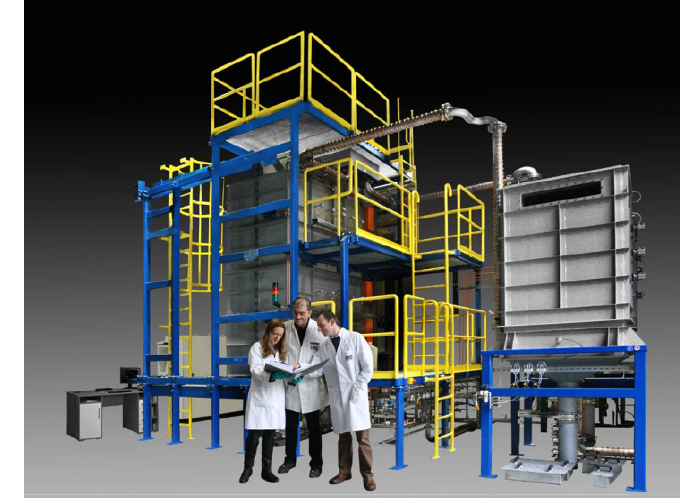
Fig. 2 – Scale up of the USP-process (J.Bogovic, S.Stopic, A.Schwinger) (Matula, et al, 2013, pp.46-50) Slika 2 – Uvecana proizvodnja za USP-proces (J.Bogovic, S.Stopic, A.Schwinger) (Matula, et al, 2013,